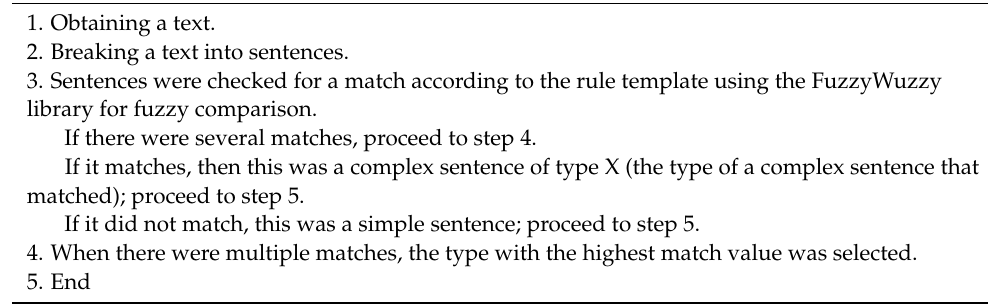
Algorithm 1 : The algorithm for determining a type of the complex sentence